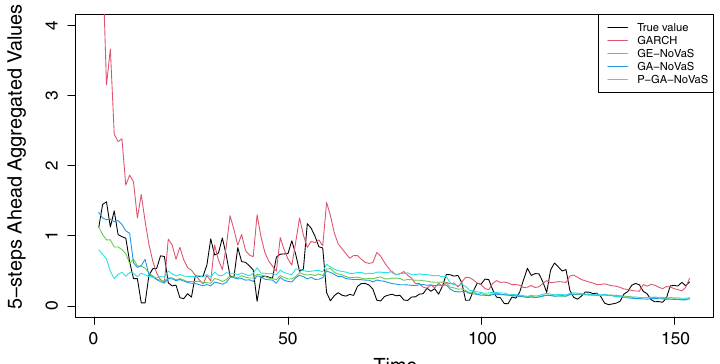
Fig. 6 The curves of different methods’ 5-steps ahead aggregated predictions on volatile CADJPY data and actual values